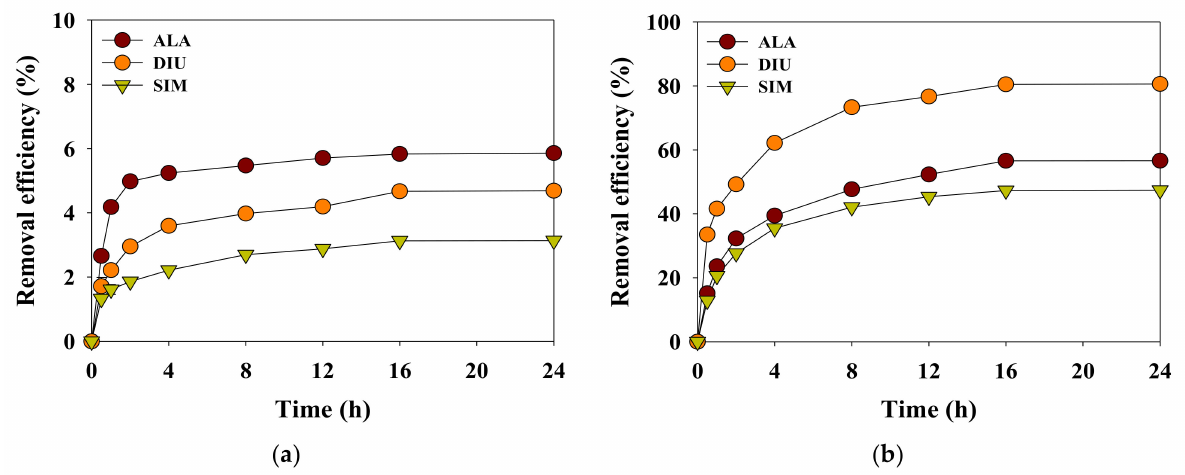
Figure 5. The adsorption kinetics of the herbicides on ( a ) the GCRB and ( b ) GCRB-N (agitation speed = 150 rpm, absorbent dosage = 50 mg/L, initial concentration of each herbicide = 10 µ M, pH = 7.0, and temperature = 25